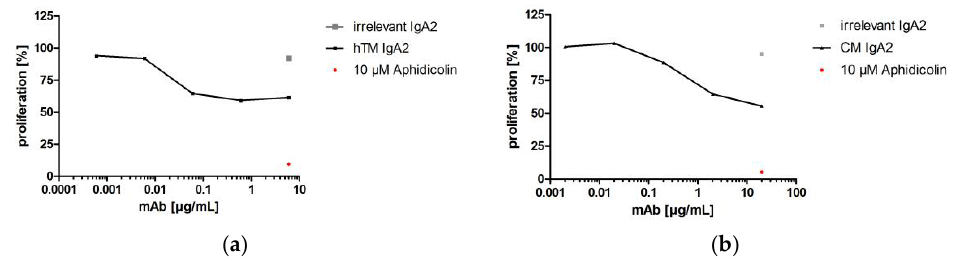
Figure 6. Inhibition of cancer cell line proliferation by hTM and CM IgA2 antibodies. Proliferation